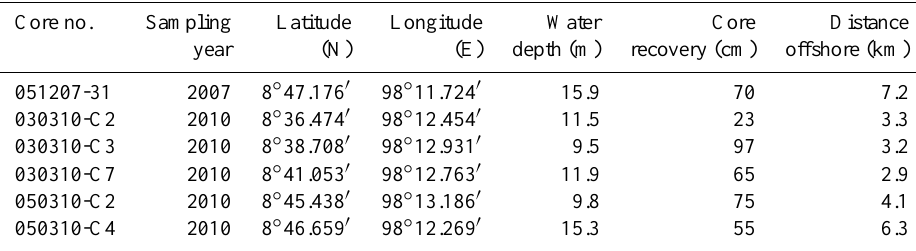
Table 2. List of the analyzed sediment cores. Core no. Sampling Latitude Longitude Water Core Distance year (N) depth (m) recovery (cm) offshore